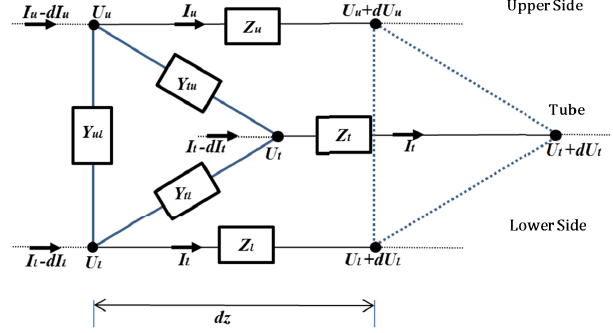
FIG. 2. Equivalent circuit from three transmission lines for an Alvarez-type